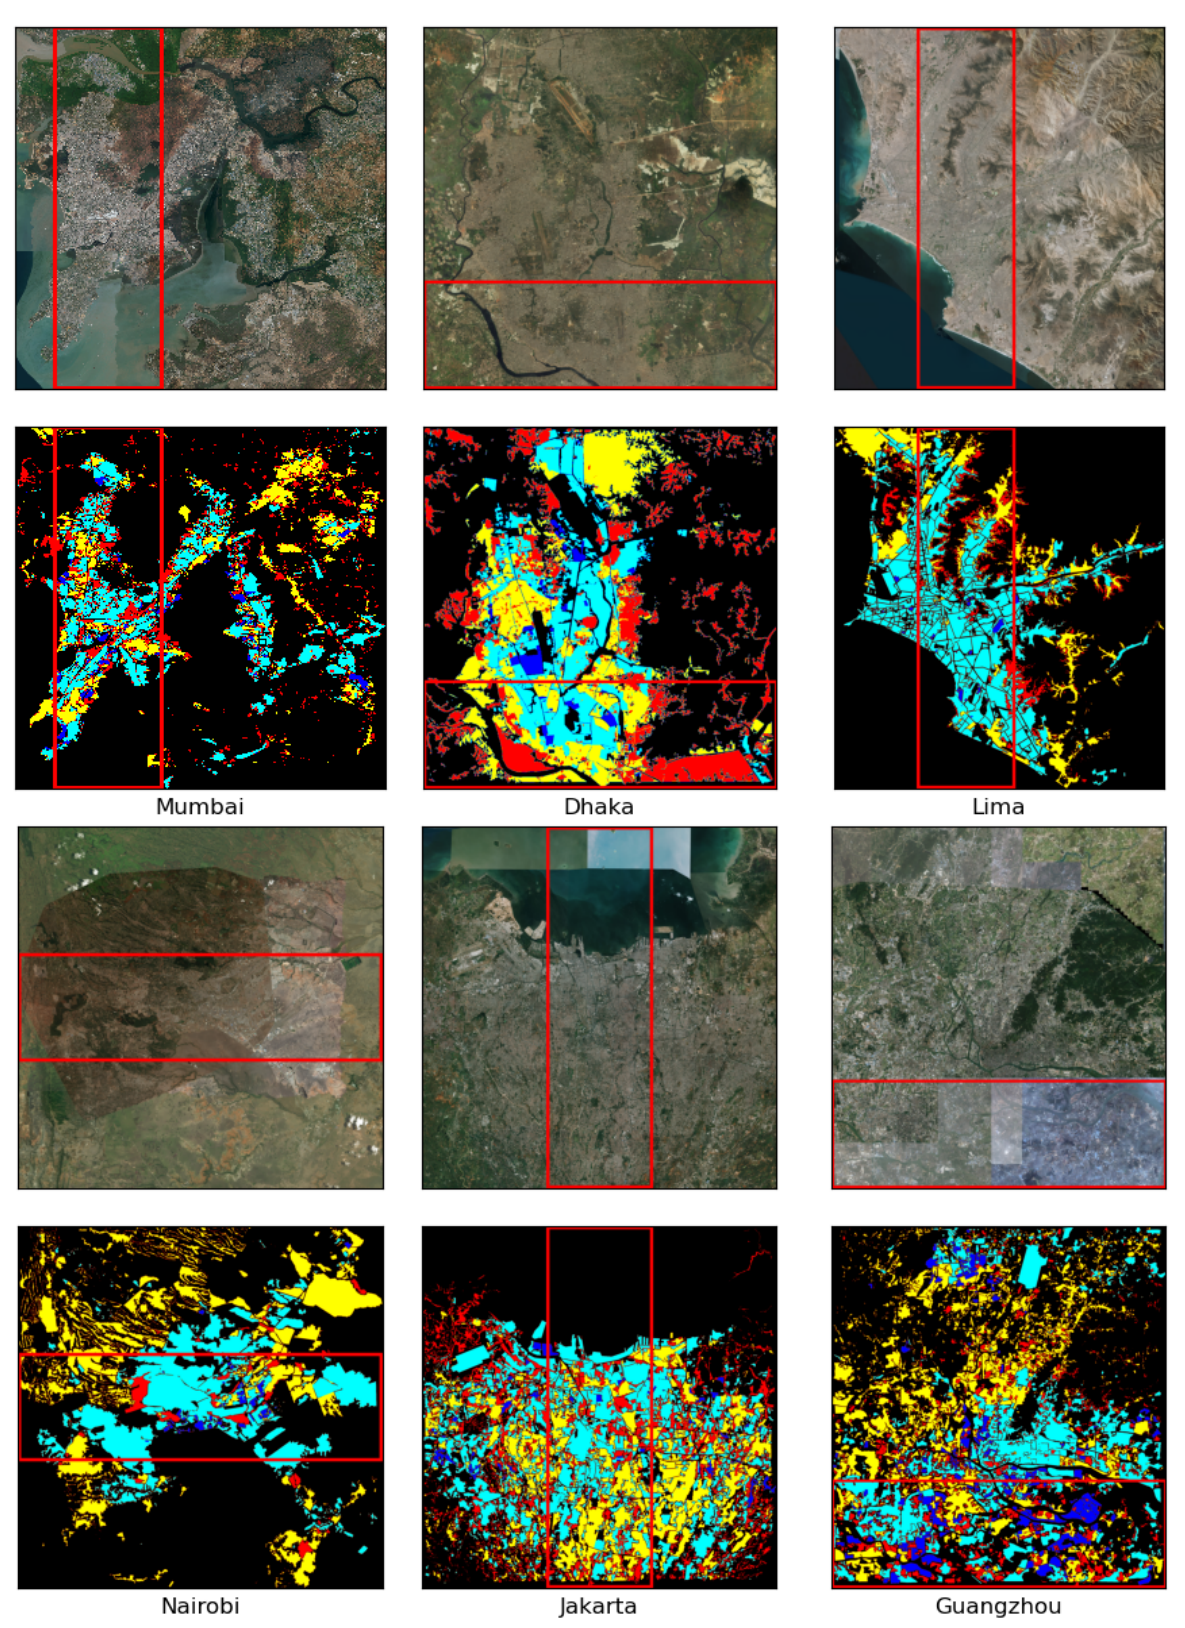
Figure 7. Input images and ground truths for other six cities. Red: highly informal area (arrival city); yellow: moderately informal area; cyan: moderately formal area; blue: highly formal area; black: uninhabited